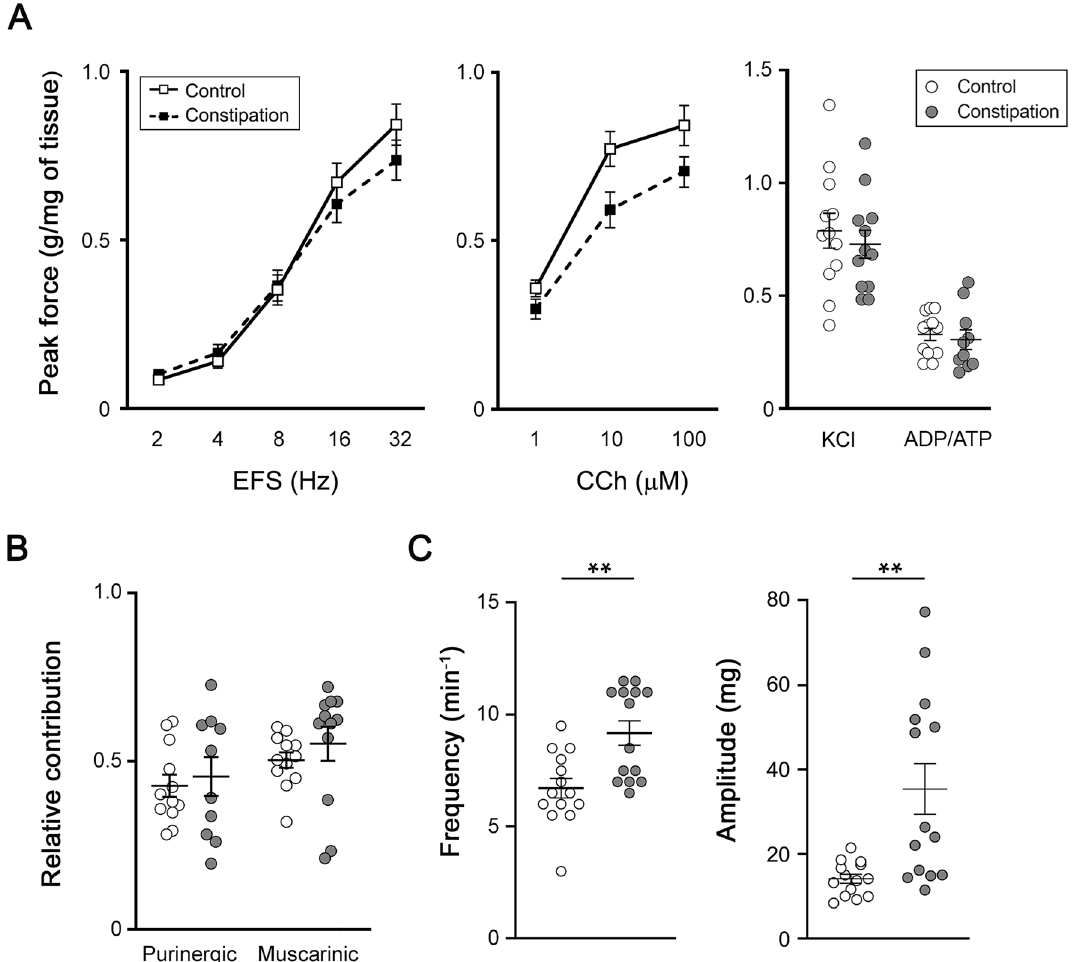
Figure 4. Detrusor contractility evaluation. ( A ) Peak contractile force in response to electric field stimulation (EFS, left), carbachol (CCh, centre), and KCl and ADP/ATP (right). ( B ) Relative contribution of purinergic and muscarinic pathways to EFS-evoked contractility. The force was normalized with tissue weight. ( C ) The frequency (left) and amplitude (right) of spontaneous contractions. White and grey circles represent the control and the constipation groups, respectively. Mean ± SE. **p < 0.005, vs. the control mice. Figures were prepared using Adobe Photoshop CS6 and GraphPad Prism 8.4.3 (https ://www.graph pad.com/scien tific -softw are/prism